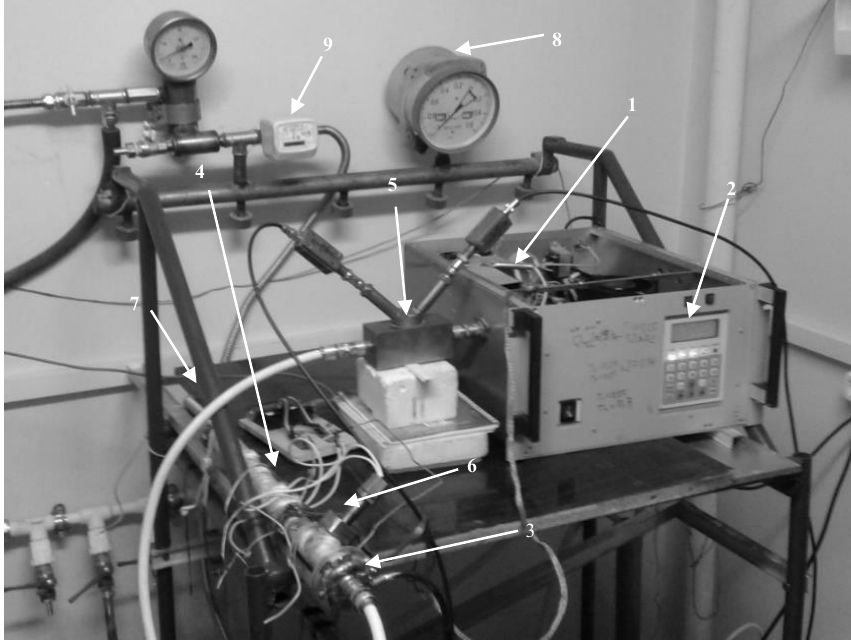
Fig. 1. Experimental setup of microwave pyrolysis of peat with coaxial resonator: (1) microwave source - industrial 2.45 GHz magnetron, (2) hvps, (3) the input device of microwave power on the basis of coaxial cables, (4) laboratory of microwave-rector on the basis of the coaxial resonator, (5) directional coupler, (6) thermocouple, (7) evacuation data analysis port with cooling-the duration of the exhaust gas fractions, (8) manometer, (9) gas